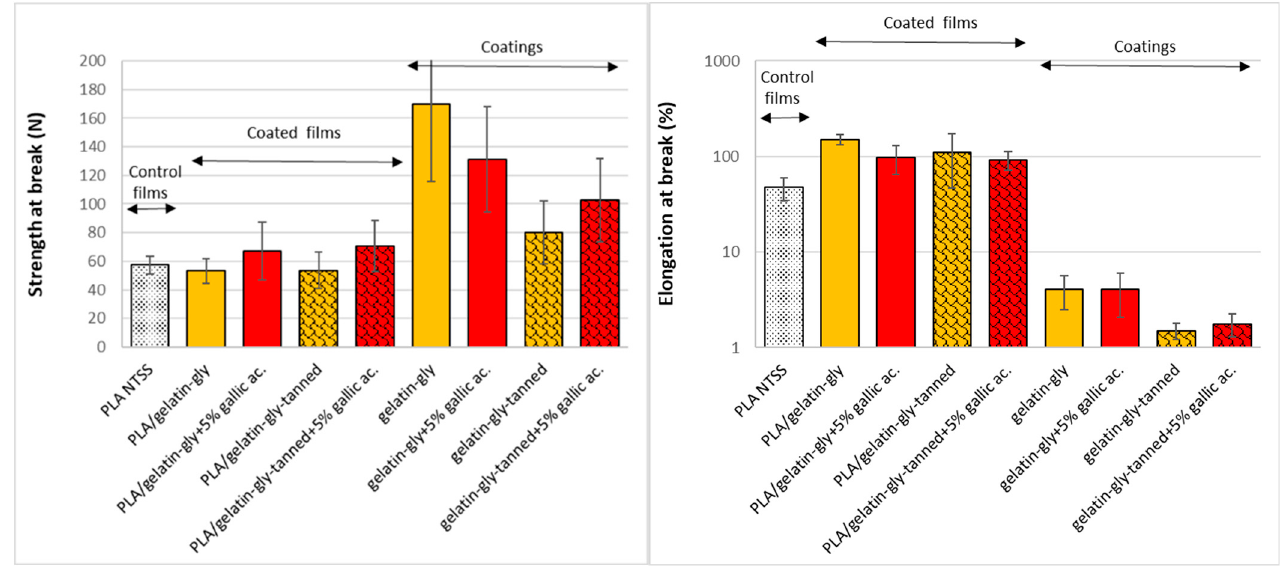
Figure 7. Influence of the coating composition on the strength and elongation at breaking, measured at 25 °C and 50% RH.